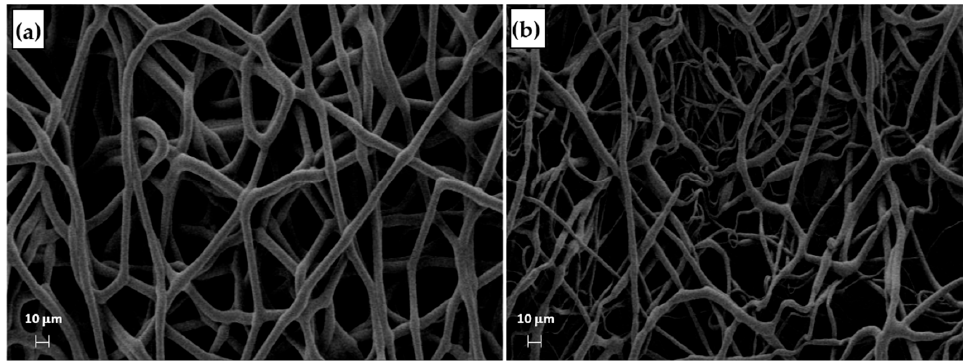
Figure 13. SEM micrographs of the bottom and top of the by-layer scaffold T-MIX: ( a ) side T3 and ( b ) side T1.